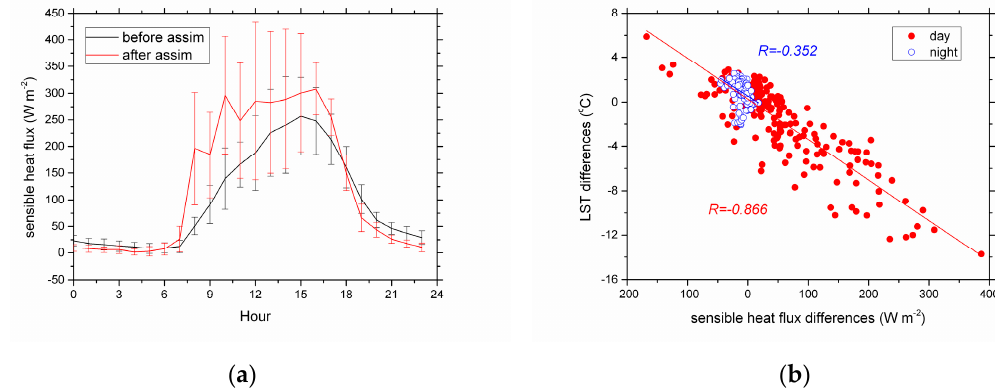
( b ) Figure 2. ( a ) Site average diurnal cycles of the tuned factor before and after assimilation; ( b ) Site average convergence processes of the assimilation algorithm. The site average convergence processes of the assimilation algorithm are shown in Figure 2b. The site average LST biases were reduced from about 7 k to 1 k in the daytime, and from 4.5 k to 1 k for the whole assimilation window. However, the LST biases were not nearly as varied at night